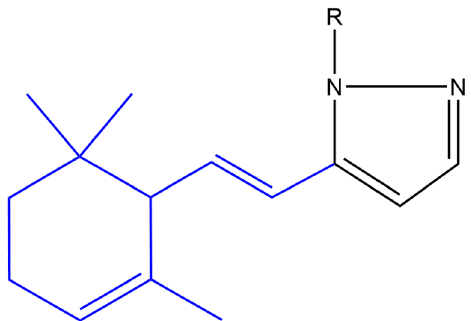
Figure 11. (Compound a ). R = H; [( E )-5-(2-(2,6,6-trimethylcyclohex-2-en-1-yl)vinyl)-1H-pyrazole] (compound b ). R = 4-amino-4 H -1,2,4-triazole-3-thiol; [(E)-4-amino-5-(5-(2-(2,6,6-trimethylcyclohex-2-en